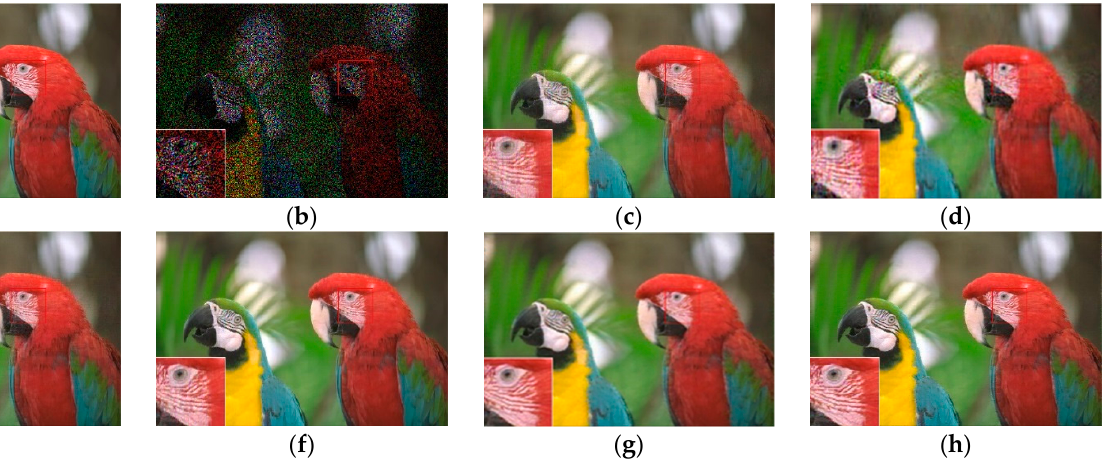
Figure 10. Visual effect comparison of different methods on the color image kodim23. The incomplete image contains 70% missing entries, shown as black pixels. ( a ) Original image; ( b ) Incomplete image; ( c ) FaLRTC (29.09 dB); ( d ) TCTF (26.94 dB); ( e ) LRTC-TNN1 (28.94 dB); ( f ) LRTC-TNN2 (29.14 dB); ( g ) LRTV-TTr1 (30.89 dB); ( h ) SLRTC (32.33 dB).